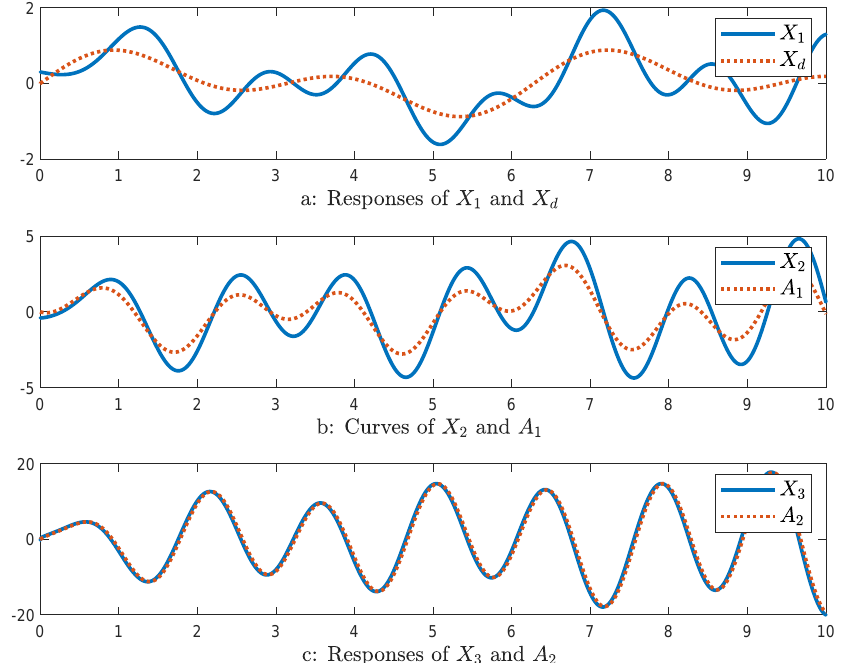
Figure 10. Output tracking performance.